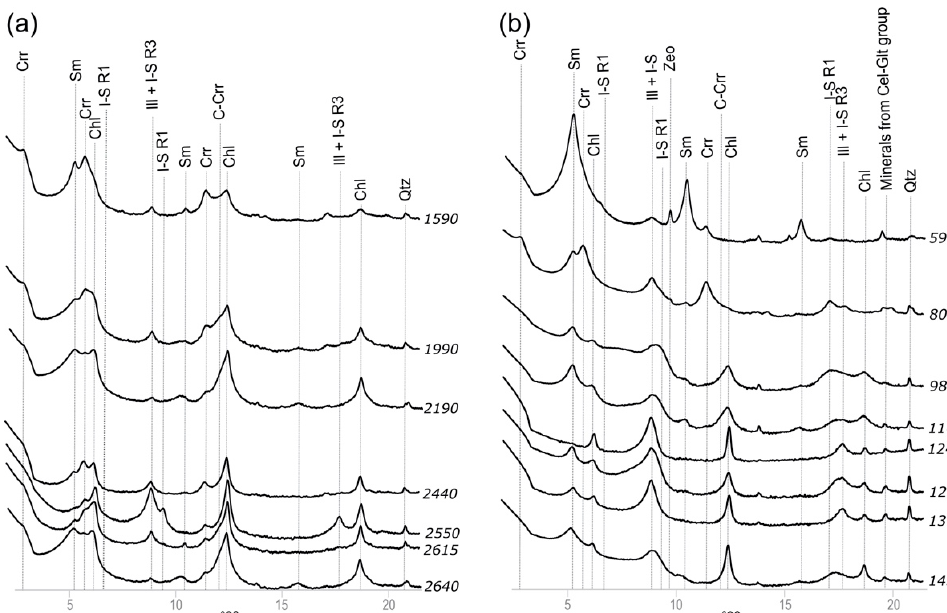
Figure 3. X-ray diffractograms of EG-saturated oriented powder ( < 5 μ m clay fraction). ( a ) Samples 1590, 1990, 2190, 2440, 2550, 2615, and 2640 in CP-4A well. Samples 2550 and 2615 were located inside the FZ associated with negative T anomaly. ( b ) Samples 590, 800, 980, 1160, 1245 (upper FZ associated with positive T anomaly), 1290, 1310 (lower FZ associated with negative T anomaly),